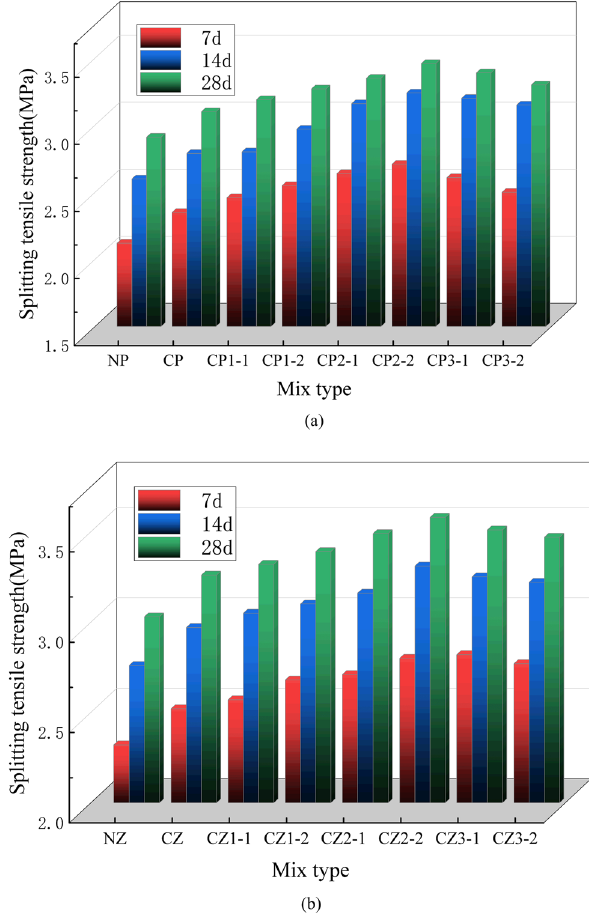
Figure 5: Splitting tensile strengths of the RAC at various ages. ( a ) Ordinary mixing mode and ( b ) vibration mixing mode.